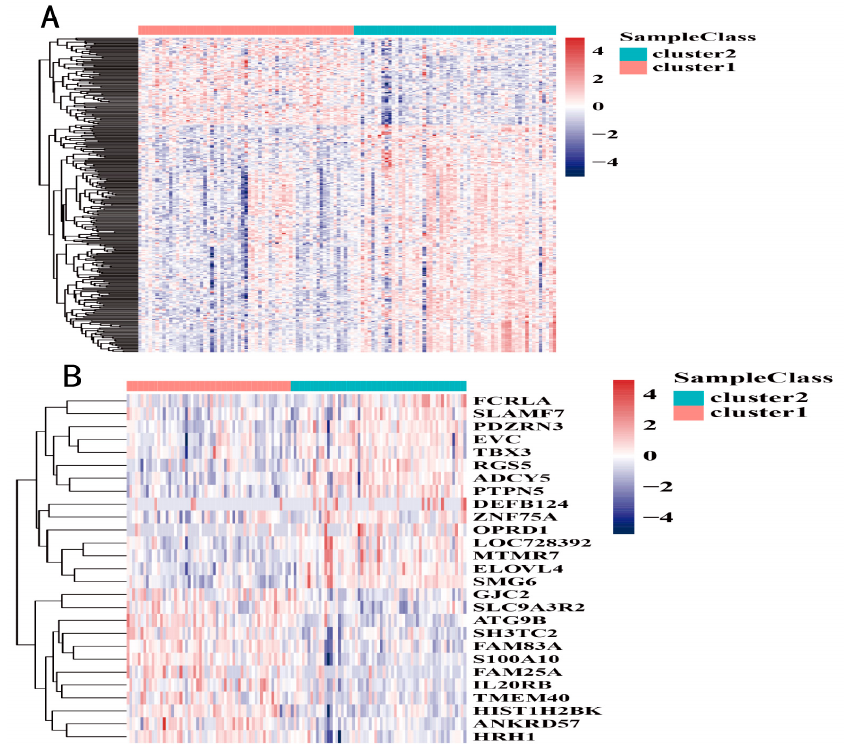
Figure 4. ( A ) Differentially expressed driver genes in two DNA methylation subtypes; ( B ) DNA methylation molecular markers differentially expressed in two DNA methylation molecular sub- types.